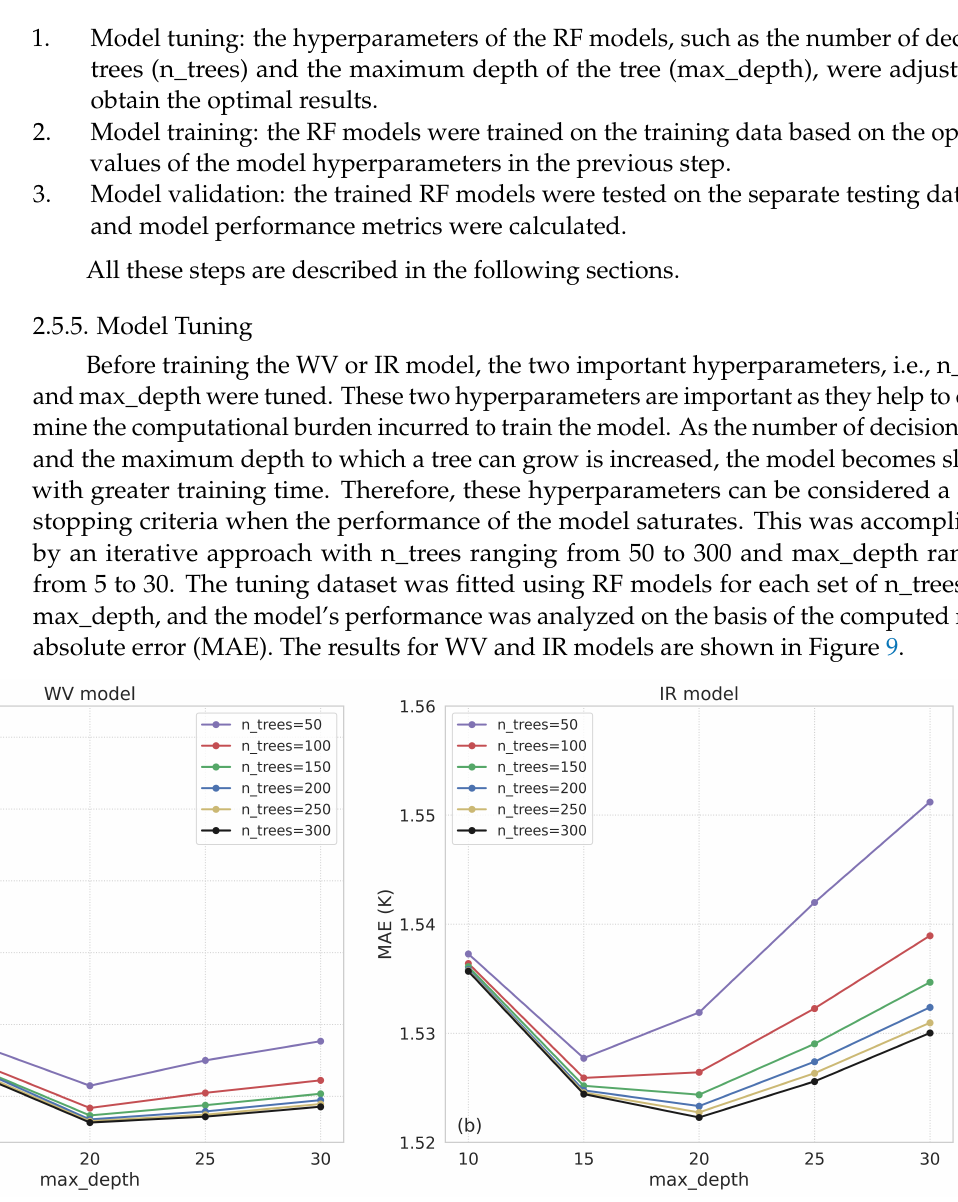
Figure 9. RF hyperparameters tuning results by visualizing the effect of number of trees (n_trees) and maximum depth of the tree (max_depth) on MAE. Results are shown for ( a ) the WV model, and ( b ) the IR model,